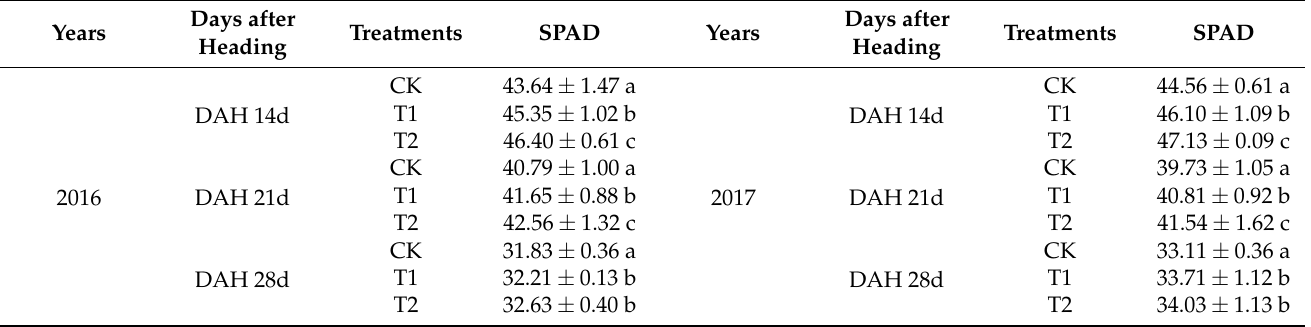
Table 3. The SPAD of rice under different treatments at different periods after heading in